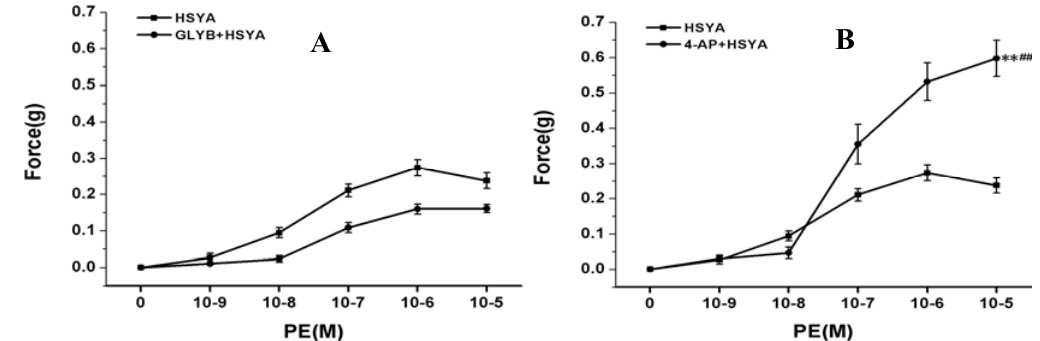
Figure 6. Vascular effect of HSYA after blocking K+ channels of PVSMCs. ( A ) Vascular effect of HSYA after pretreatment with GLYB; ( B ) Vascular effect of HSYA after pretreatment with 4-AP; ( C ) Vascular effect of HSYA after pretreatment with Bacl2; ( D ) Vascular effect of HSYA after pretreatment with TEA; ( E ) Bar graph shows the vascular effect of HSYA after blocking the different K+ channels of PVSMCs. ** indicates the result has statistical significance ( p < 0.01, compared with Control). ## p < 0.01 compared with